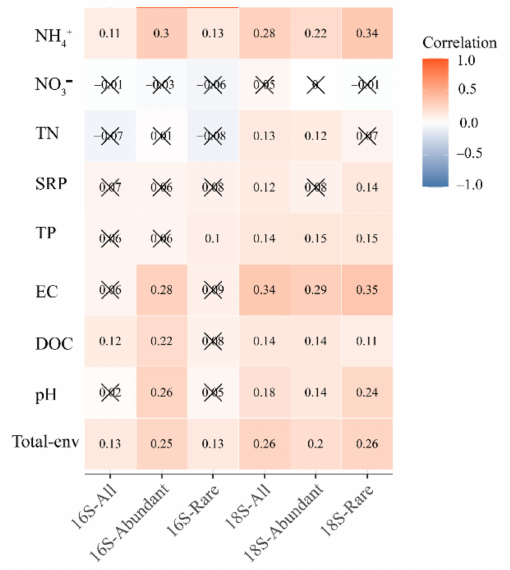
Figure 3. Spearman’s correlations of the bacterial and microeukaryotic communities with environ- mental factors based on the Mantel test. The magnitudes of the correlation coefficients are shown without a cross when the correlation is significant ( p <